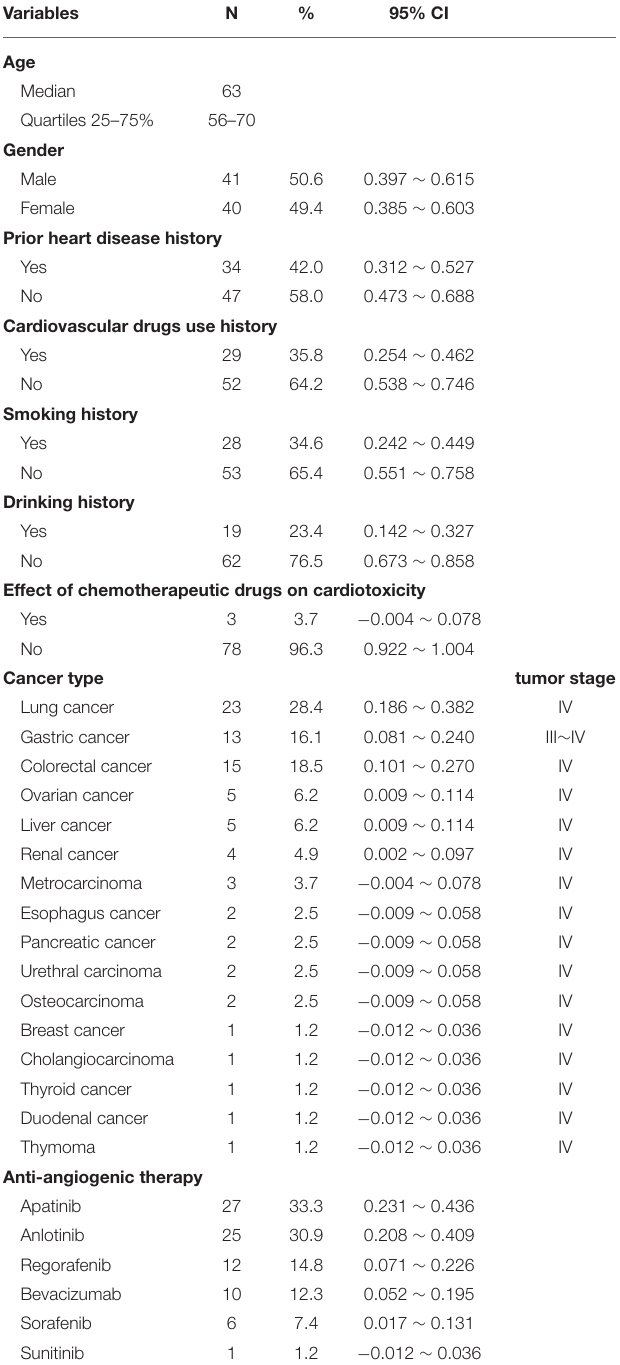
TABLE 1 | Patients’